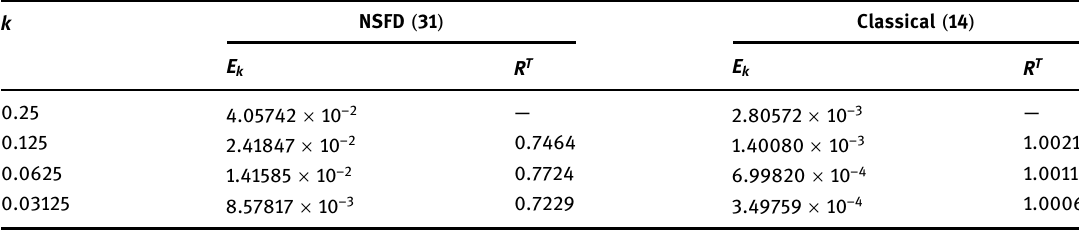
Table 3: Rate of convergence in time using experiment 2 for NSFD and classical for = h 0.02 at time = t 10.0